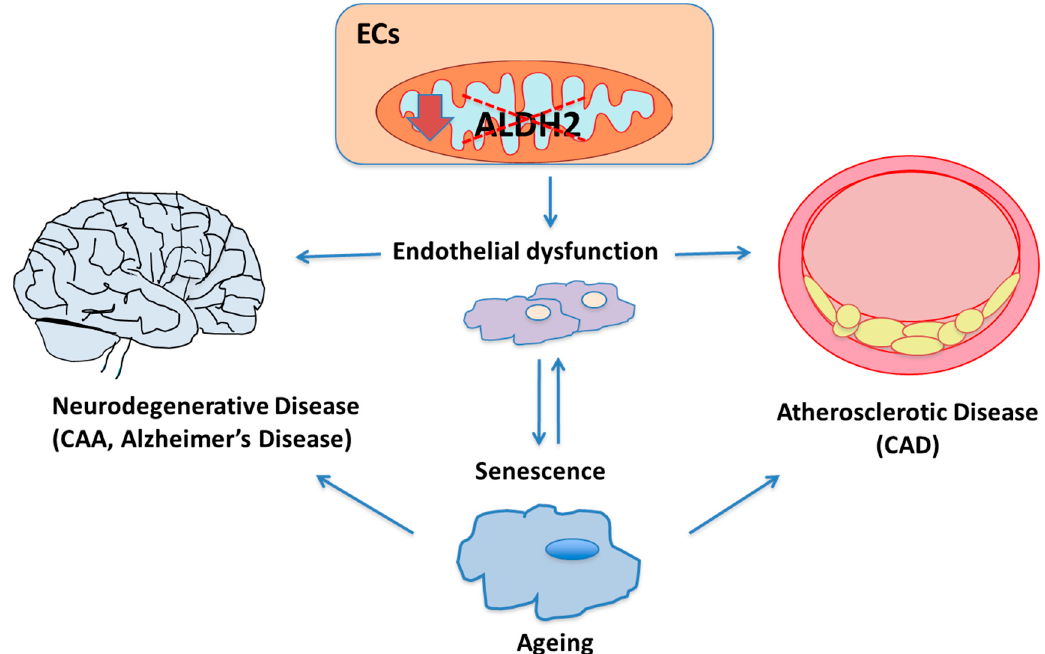
Figure 1. The role of aldehyde dehydrogenase-2 (ALDH2) in endothelial function and endothelial-related diseases. ALDH2 downregulation (down arrow) and/or catalytic inactivation (dashed red lines) into mitochondria in endothelial cells (ECs), leading to inefficient aldehyde metabolism, is recognized to affect endothelial functions and make senescence occur faster. Senescence itself might further aggravate endothelial dysfunction. In turn, ALDH2 is believed to be involved in the ageing process, in particular ageing related-cardiovascular diseases, such as atherosclerosis and coronary artery disease (CAD), and affect the cerebrovascular unit, contributing to the etiology of neurovascular degenerative diseases, including Cerebral Amyloid Angiopathy (CAA).